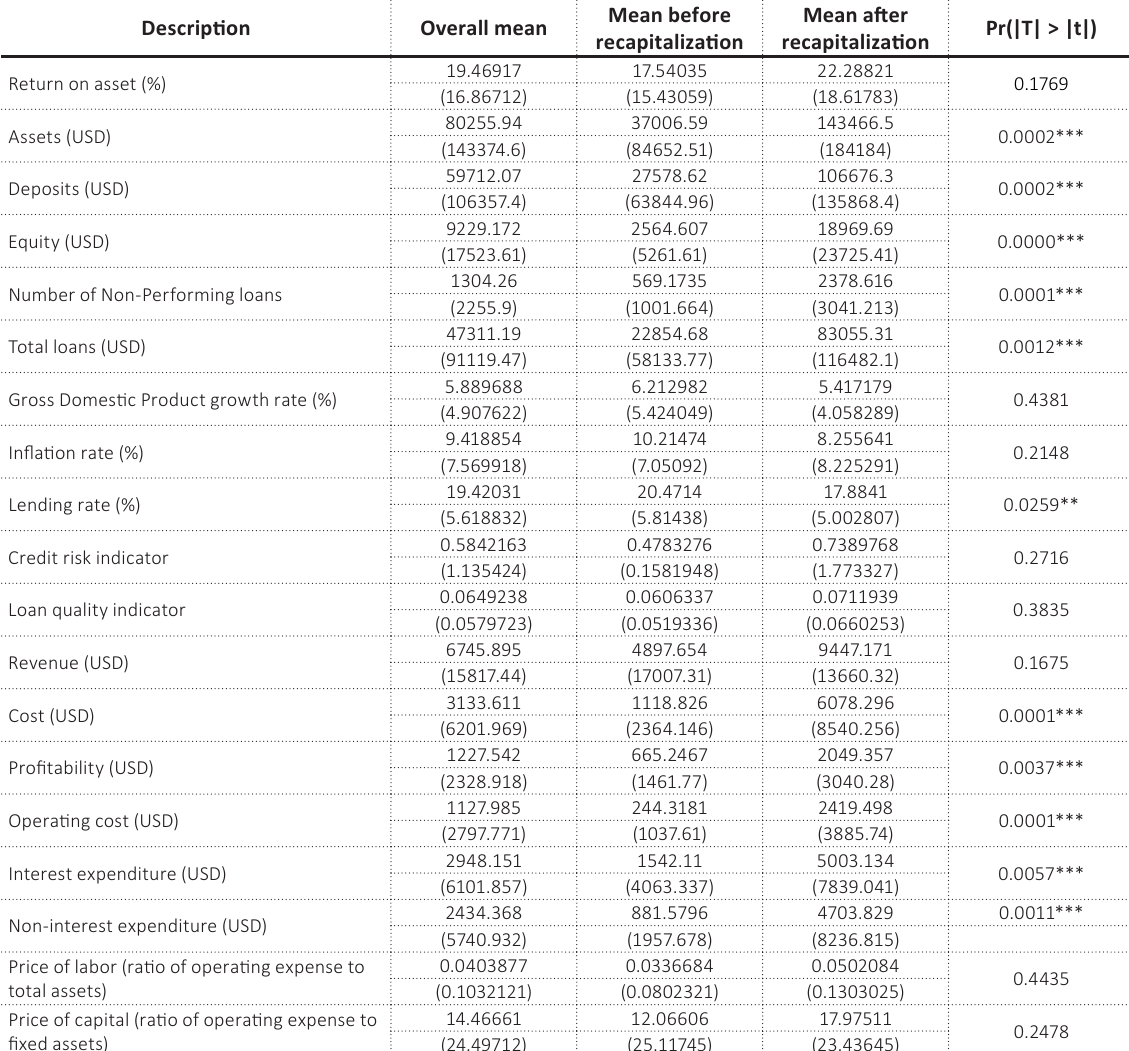
Table 2. Summary statistics of